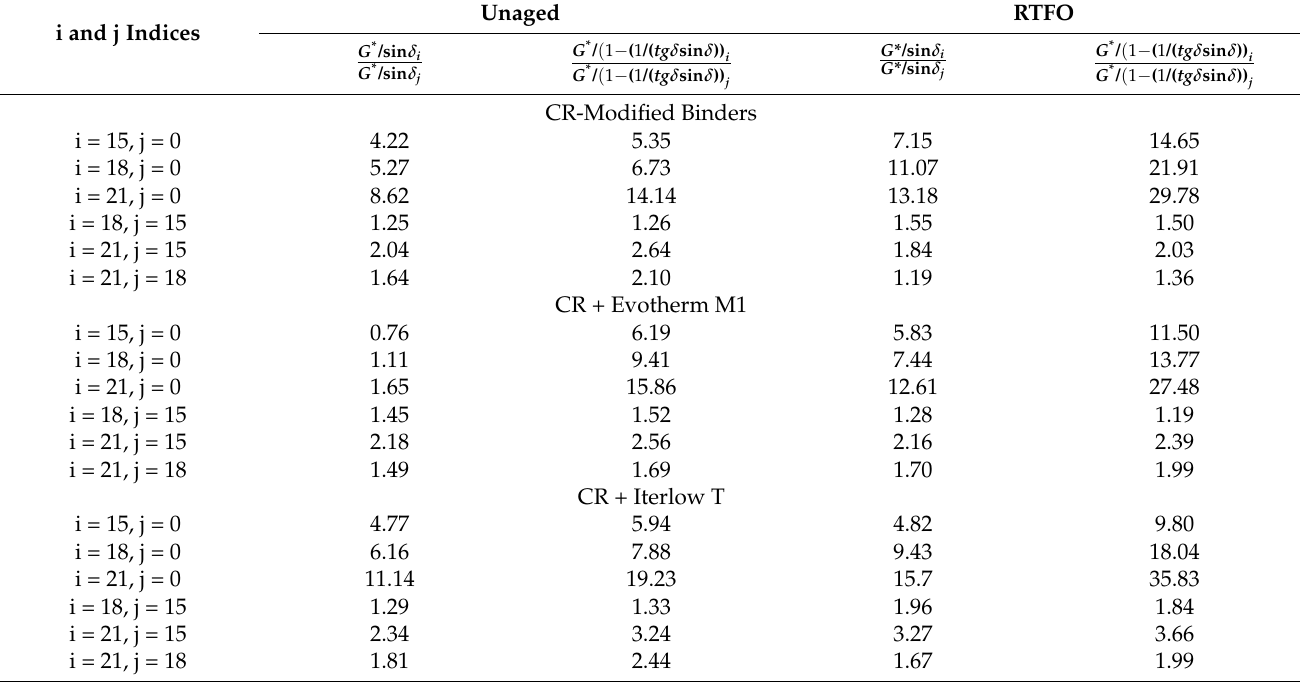
Table 4. The effect of CR content, and WMA additives on the values of SHRP. The ratio of rutting parameter of i% CR-modified binder to that of modified with j%